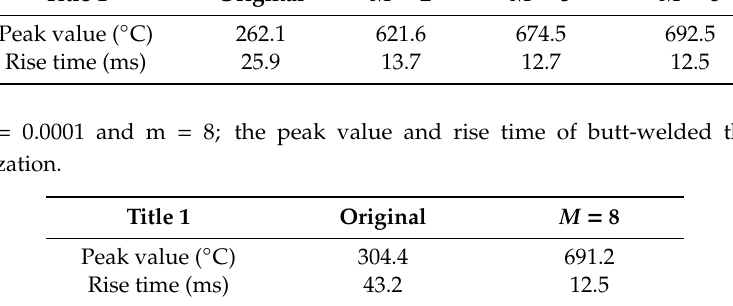
Table 1. σ = 0.0001 and m = 2, 5, 8; the peak value and rise time of butt-welded thermocouple after regularization.